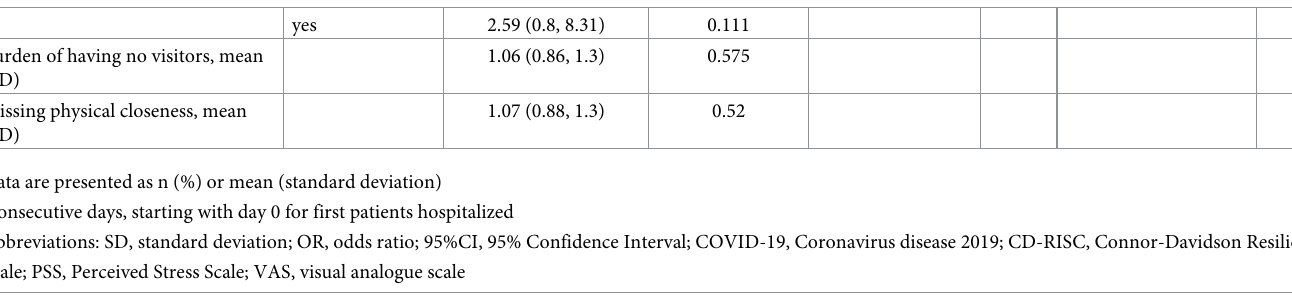
Table 3A and 3B provide an overview of the different variables and associations with psy- chological